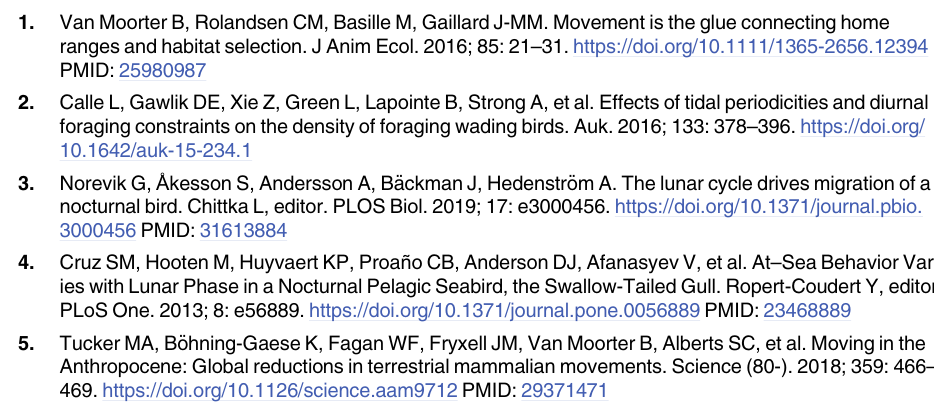
S2 Table. Step length model selection. Model selection results for evaluating differences in foraging step length among wetland habitat types, while accounting for water depth, by GPS- tagged great egrets at Tomales Bay, CA, 2017–2020. K is the number of parameters, Δ AICc is the difference in AICc value between the top model and the current model, and AICc Wt. is the AICc model